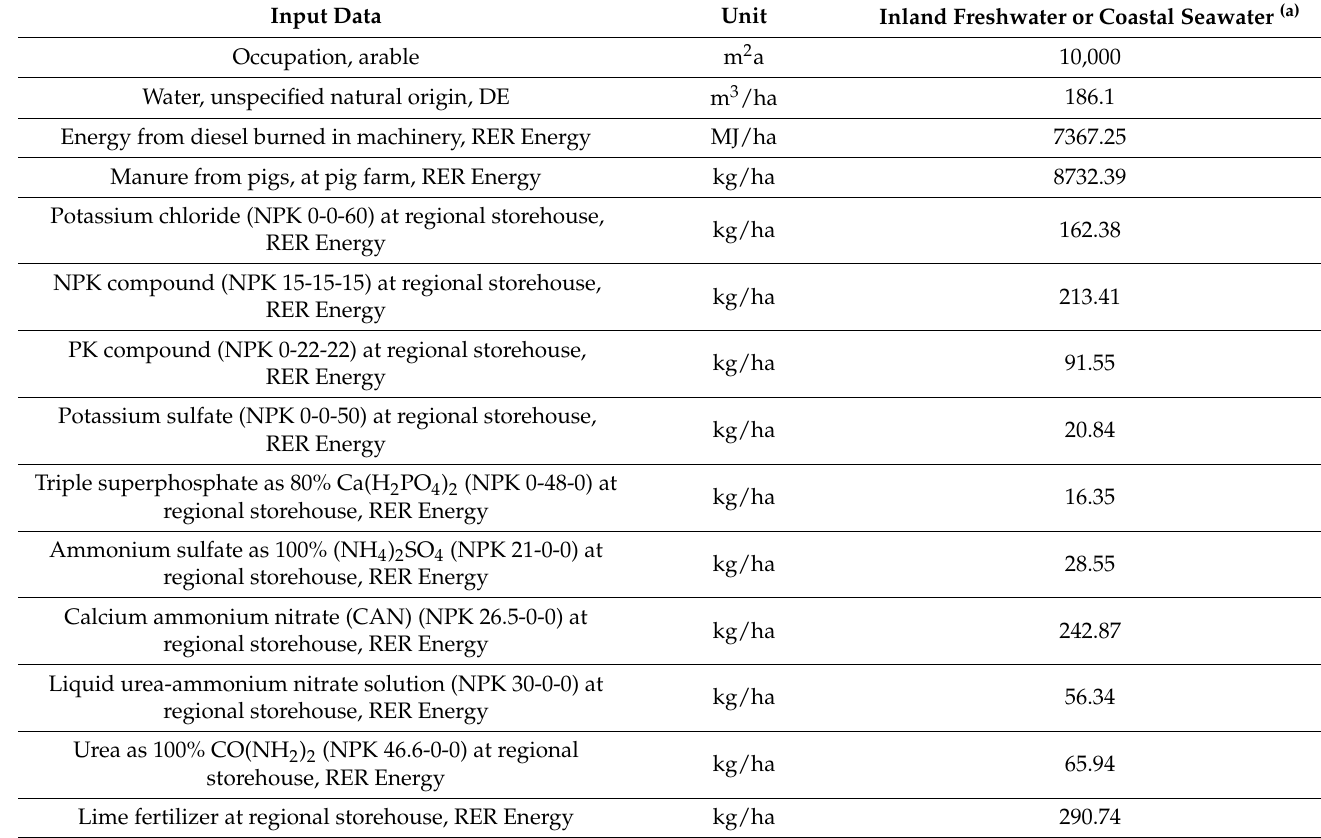
Table 1. Life cycle inventory for the cultivation and harvesting of sugar beet (SB), which is identical to the Inland Freshwater and Coastal Seawater